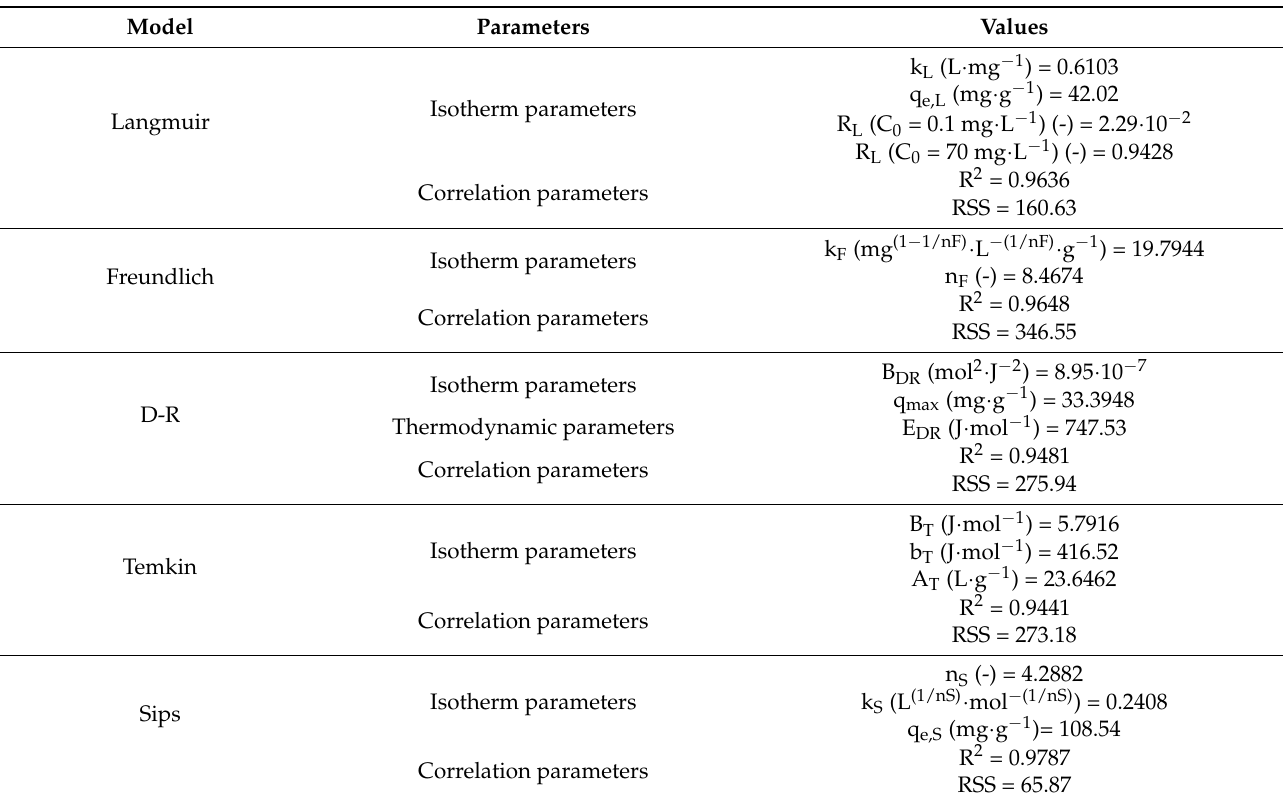
Table 1. Adjusted isotherm model parameters to hexavalent chromium adsorption onto CCNC experimental